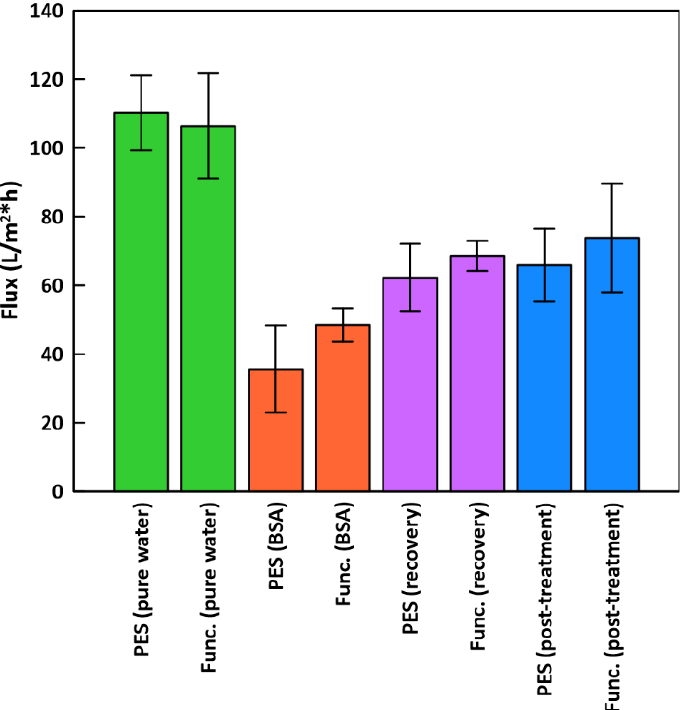
Figure 10. Dead-end filtration flux for PES and functionalized membranes. “Func.” results are for functionalized PES/PDA/MPC/CuO membranes.